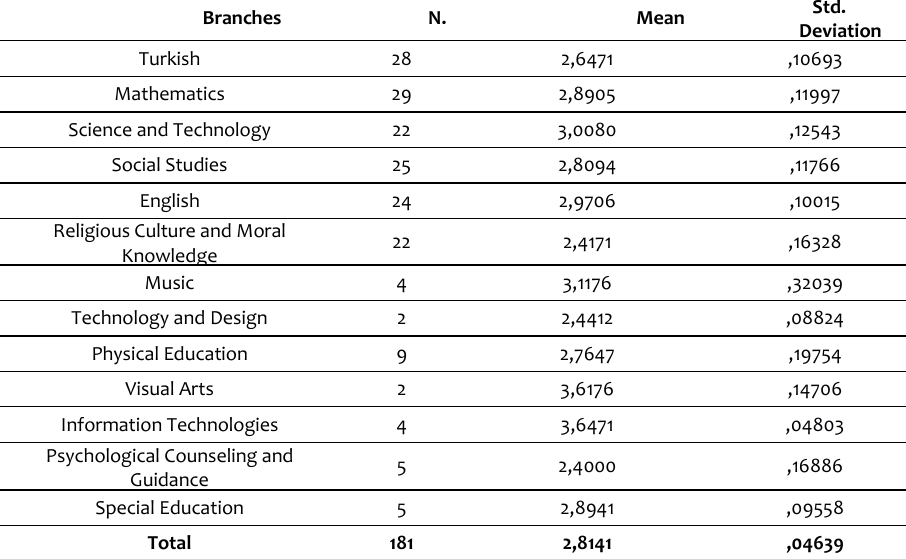
Table 4. Descriptive statistics on scores of teachers' attitude scale according to branch